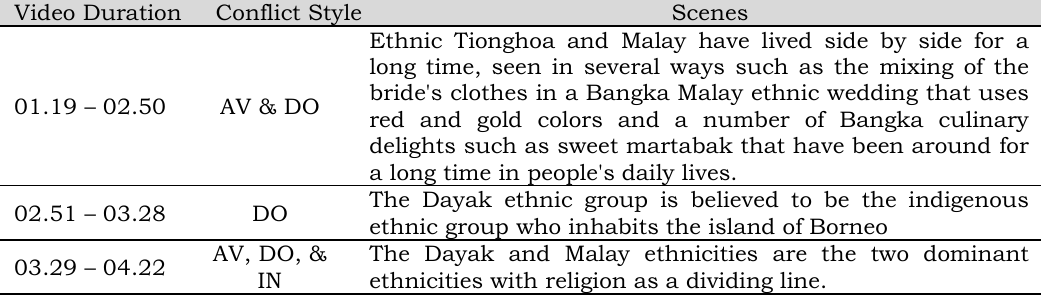
Table 3. Meaning of conflict style in video as Index Video Duration Conflict Style Scenes long time, seen in several ways such as the mixing of the delights such as sweet martabak that have been around for a long time in people's daily lives. The Dayak ethnic group is believed to be the indigenous ethnic group who inhabits the island of Borneo The Dayak and Malay ethnicities are the two dominant IN ethnicities with religion as a dividing